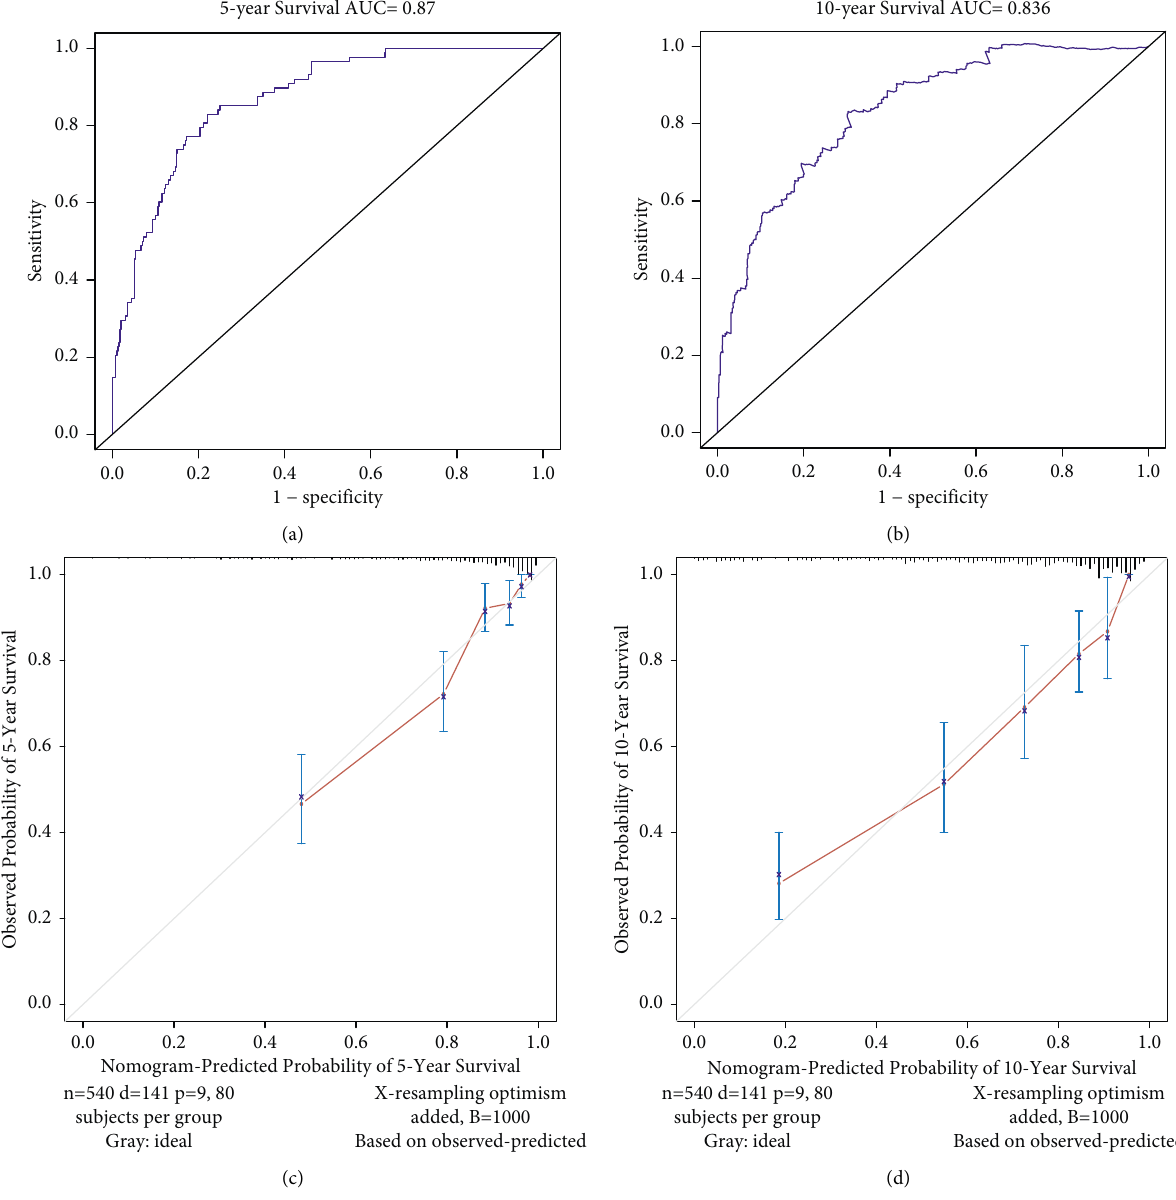
Figure 5: The ROC curves of the prognostic nomogram for predicting the 5-year (a), and 10-year survival (b) in COPD. The calibration curves of the prognostic nomogram for predicting 5-year (c) and 10-year survival (d) in